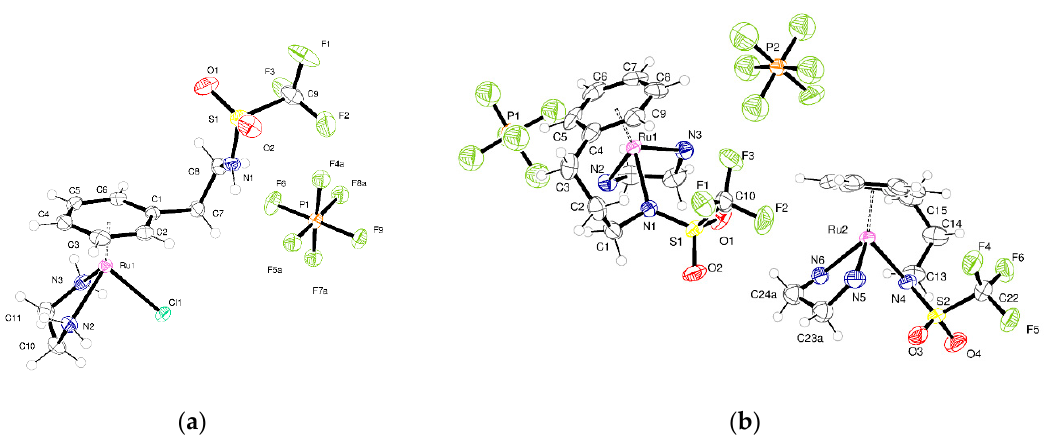
Figure 4. ( a ) Asymmetric unit of 3 with atoms shown as 50% displacement parameters (small-scale disorder in the anion is not shown); ( b ) Asymmetric unit of 4 with atoms shown as 50% displacement parameters (small-scale disorder in the anion is not shown).